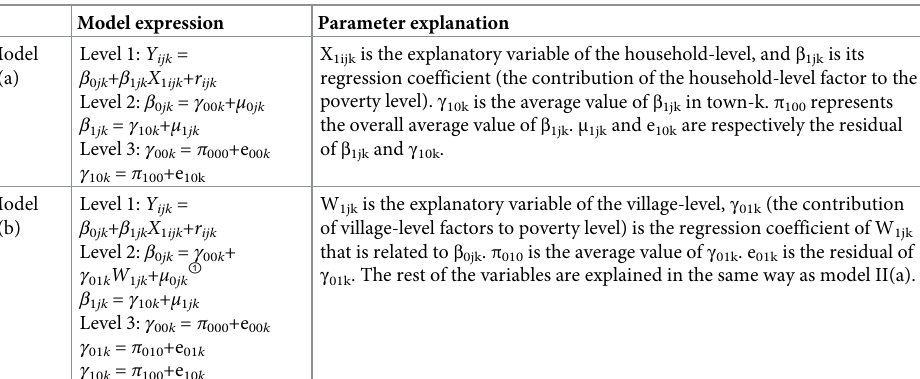
Table 3. Random effect regression model.